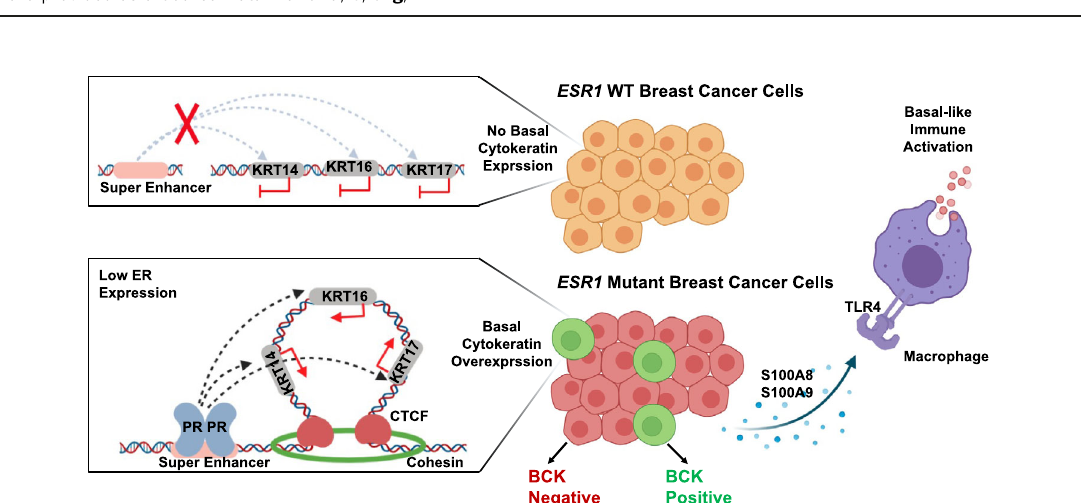
Fig. 6 Immune activation in ESR1 mutant tumors is associated with S100A8/A9-TLR4 paracrine crosstalk. a Expressional fold changes of immune genes from ESTIMATE ( n = 141) 73 comparing ER + BCK-high vs. low tumors (TCGA and METABRIC) and ESR1 WT/mutant tumors. Consistently increase, decreased or inconsistent genes in are highlighted in red, blue, and black. b BCK-high and low quantiles of ER + tumors were further divided by the mean of S100A8 and S100A9 . Immune scores were compared across all four subsets ( n = 188 and 101 per group of METABRIC and TCGA) together with basal tumors ( n = 328 METABRIC and n = 190 TCGA). Box plots span the upper quartile (upper limit), median (center) and lower quartile (lower limit). Whiskers extend a maximum of 1.5× IQR. Mann – Whitney U -test (two-sided) was used. c Graphical presentation of experimental strategy of d . d S100A8/ 9 heterodimer concentrations in plasma from patients with ESR1 WT ( n = 7) and mutant ( n = 11) metastatic breast cancer. Box plots span the upper quartile (upper limit), median (center) and lower quartile (lower limit). Whiskers extend a maximum of 1.5× IQR. Mann – Whitney U -test (two-sided) was utilized. This experiment was done once. e TLR4 and RAGE signature enrichments between ESR1 mutant ( n = 7) and WT ( n = 44) tumors. Delta GSVA score was calculated by subtracting the scores of primary tumors from the matched metastatic tumors. Box plots span the upper quartile (upper limit), median (center), and lower quartile (lower limit). Whiskers extend a maximum of 1.5× IQR. Mann – Whitney U -test (two-sided) was performed. f Violin plots showing expression of four genes by log2 normalized counts in different cell subtypes using single-cell RNA-seq data from two ER + bone metastases. g Percent of cells expressing S100A8 , S100A9 , TLR4 , and AGER , using single cell RNA seq data shown in f . h Immuno fl uorescent staining of S100A8/A9 with CD45 or EpCAM in a Y537S ESR1 mutant liver metastasis. Double positive cells are pointed out and magni fi ed. This experiment was done once. i Percentage of S100A8/A9 + cells overlapped with EpCAM + or CD45 + cells. Data were quanti fi ed based on six representative regions of the section. Source data are provided as a Source Data fi le for a , b , d – g , i .